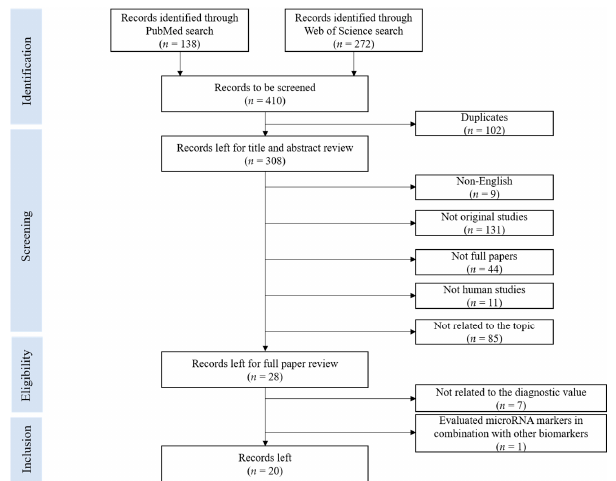
Figure 1. PRISMA flow diagram for literature search process for records identified via PubMed and Web of Science database.